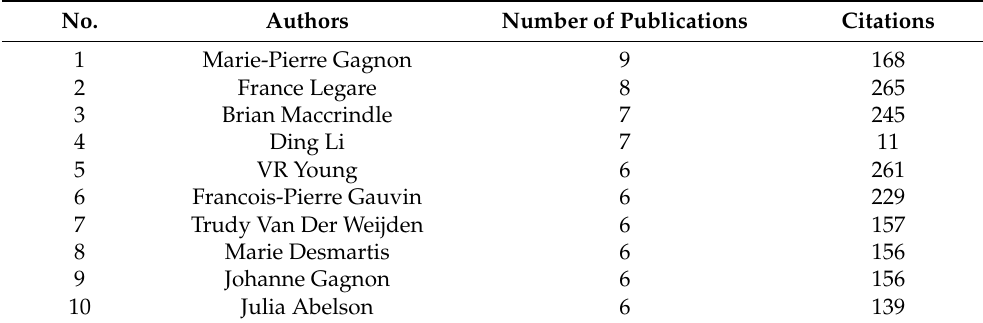
Table 2. Top 10 authors in the field of health technology.